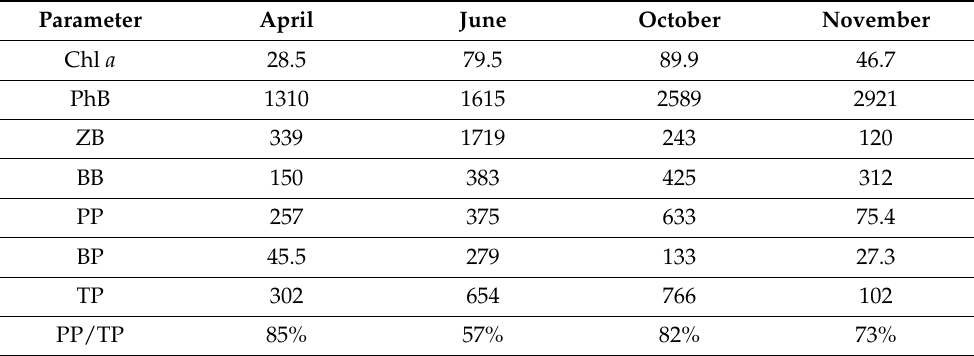
Table 1. Depth-integrated values of chlorophyll a content (Chl a , mg/m 2 ), phytoplankton biomass (PhB, mgC/m 2 ), zooplankton biomass (ZB, mgC/m 2 ), bacterial biomass (BB, mgC/m 2 ), pri- mary production rate (PP, mgC/m 2 per day), bacterial production (BP, mgC/m 2 per day), total (bacterial + primary) production (TP = PP + BP, mgC/m 2 per day), share of integral primary produc- tion of total production (PP/TP) in euphotic